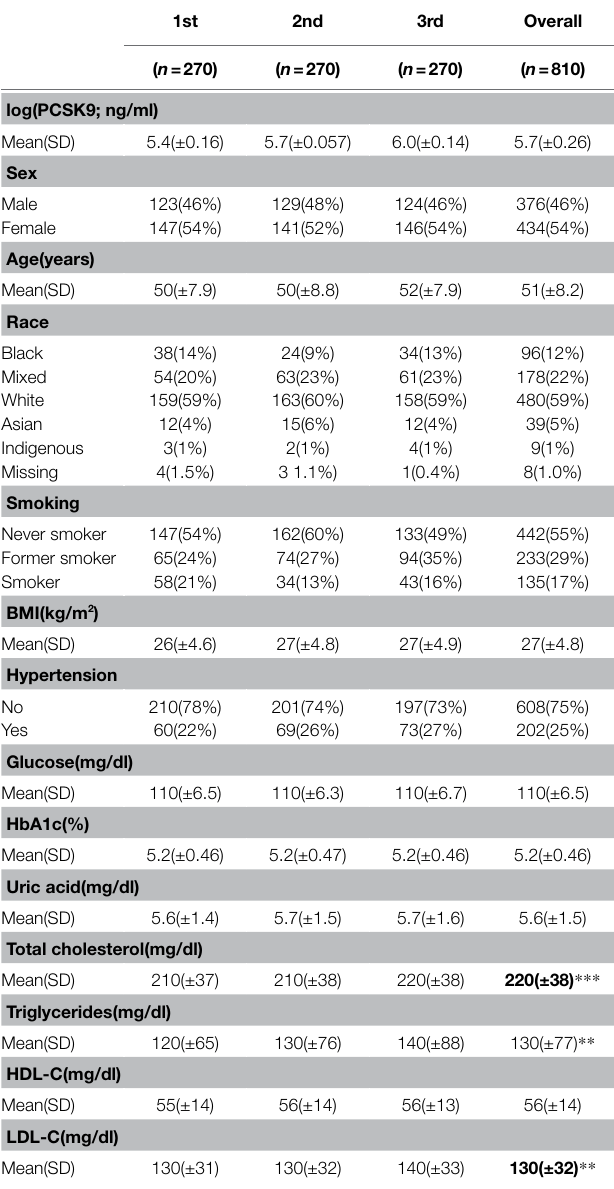
TABLE 1 | Clinical and laboratory characteristics of studied subjects according to tertiles of plasma PCSK9